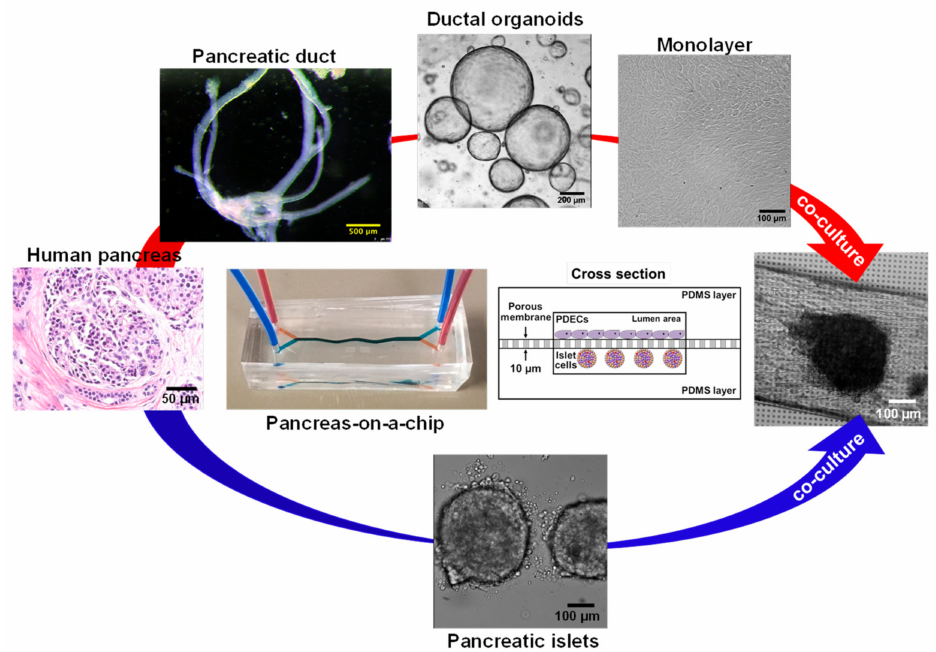
Figure 5. In vitro co-culturing model, pancreas-on-a-chip [55]. The pancreas-on-a-chip is composed of two cell culture chambers and a thin layer of porous membrane. Patient-derived pancreatic ductal epithelial cells were plated in the top chamber and polarized on the porous membrane over 4 days. By adding patient-derived islets in the bottom chamber, it mimics the in vivo